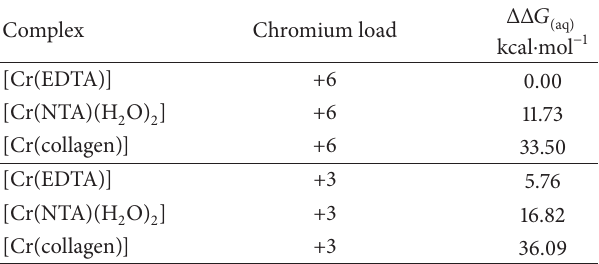
Table 2: Relative Gibbs free energy values for the complexation ). reaction in solution ( ΔΔ𝐺 (aq)